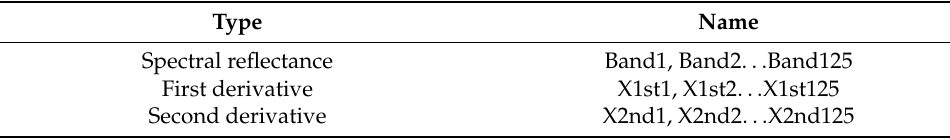
Table 3. List of the spectral features for hyperspectral